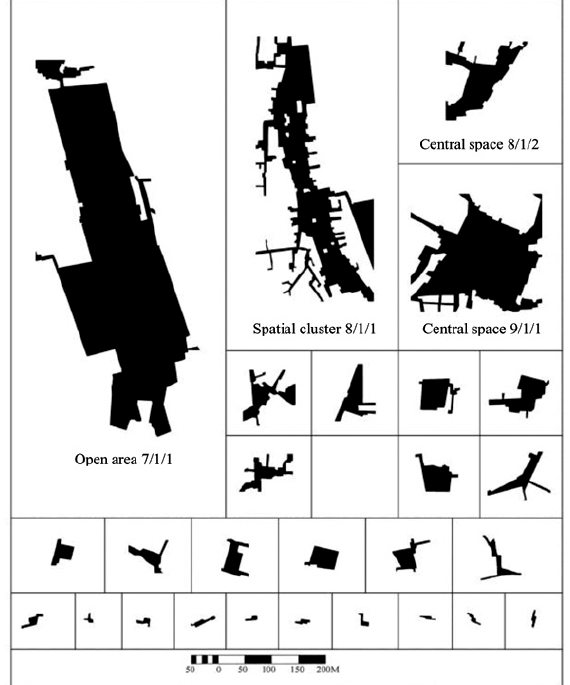
Fig.3. Cairo Citadel area, a concentration of central urban spaces’, the Napoleon map